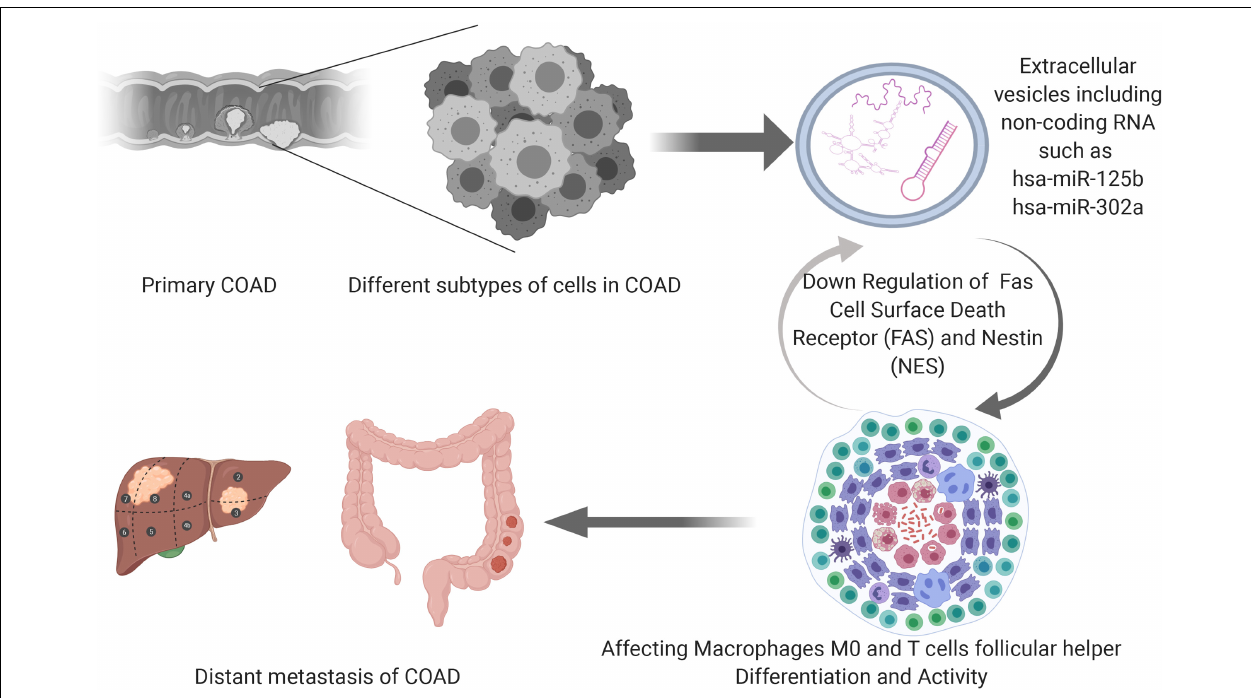
FIGURE 10 | The speculative mechanism diagram containing key ceRNAs and immune